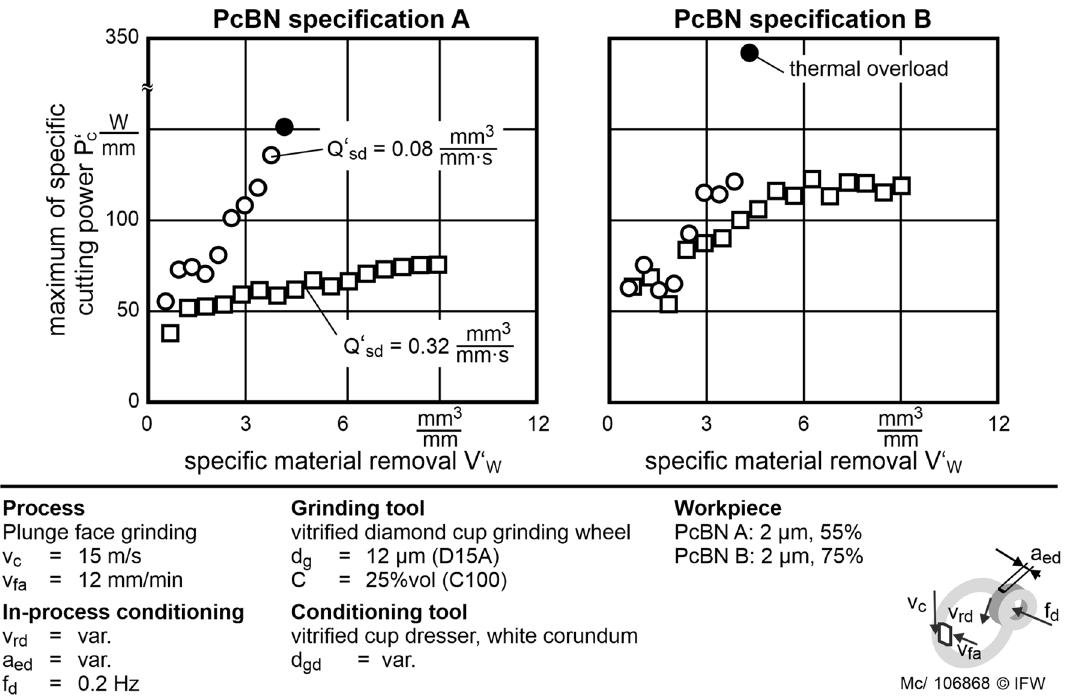
′ Figure 8. Influence of Q sd on the maximum specific spindle power with 16 grinding tool engagements. At low Q ′ sd the tests had to be stopped because of thermal